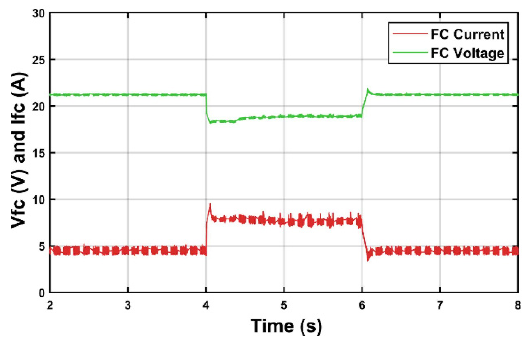
Figure 13. PEMFC emulators current and voltage.